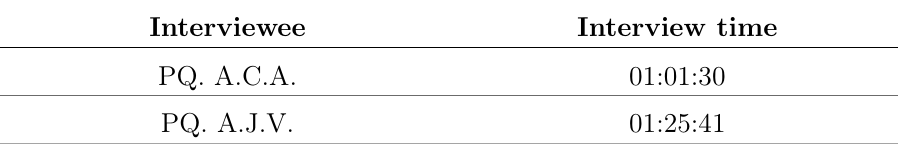
Table 1. Coding List and Interview